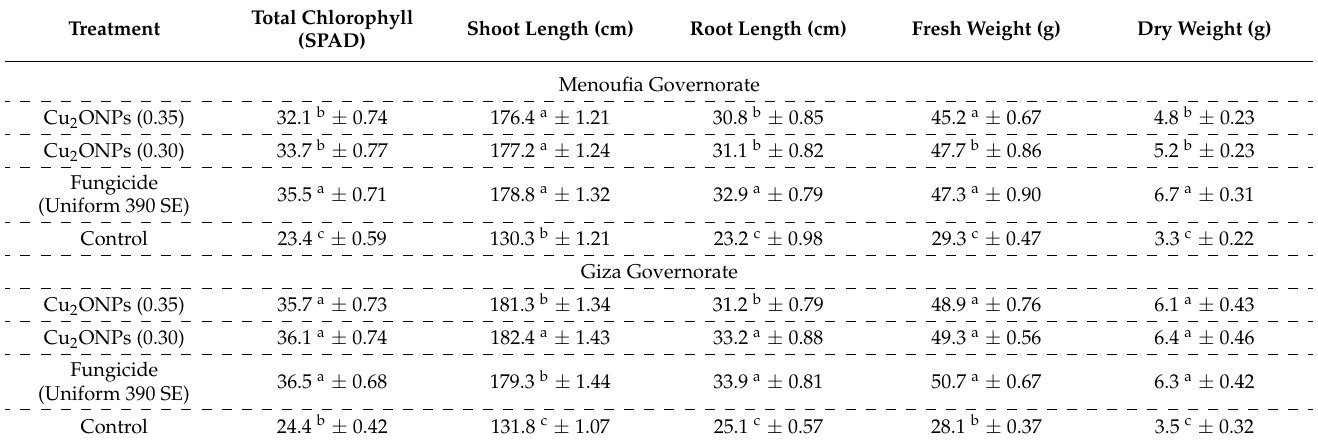
Table 6. Effect of Cu 2 ONPs compared to the chemical fungicide on total chlorophyll and growth parameters of cucumber plants under field conditions in Menoufia and Giza Governorates.